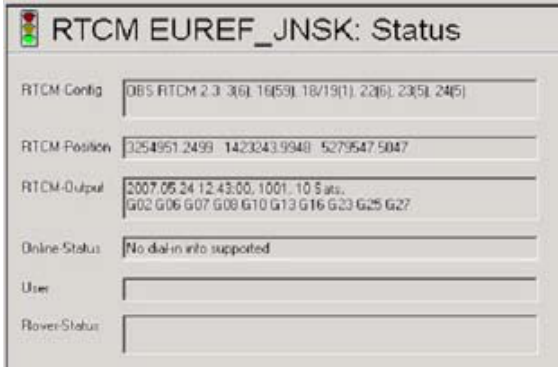
Fig. 11 . Information on broadcasting stations